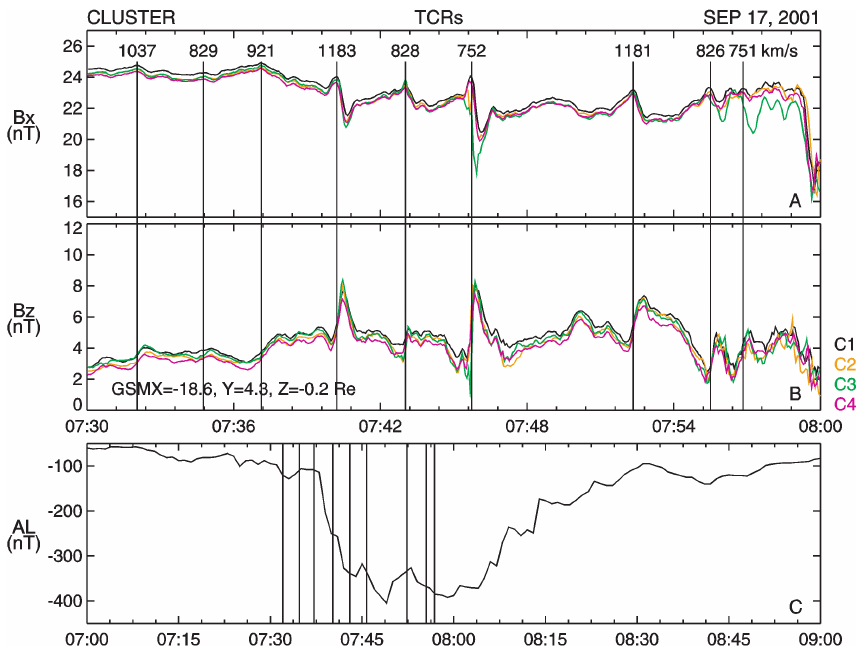
Fig. 7. Example of TCRs observed by Cluster during a substorm on 17 September 2001. The propagation speed of the TCRs, all Earthward, are shown in the top panel. (From Slavin et al.,